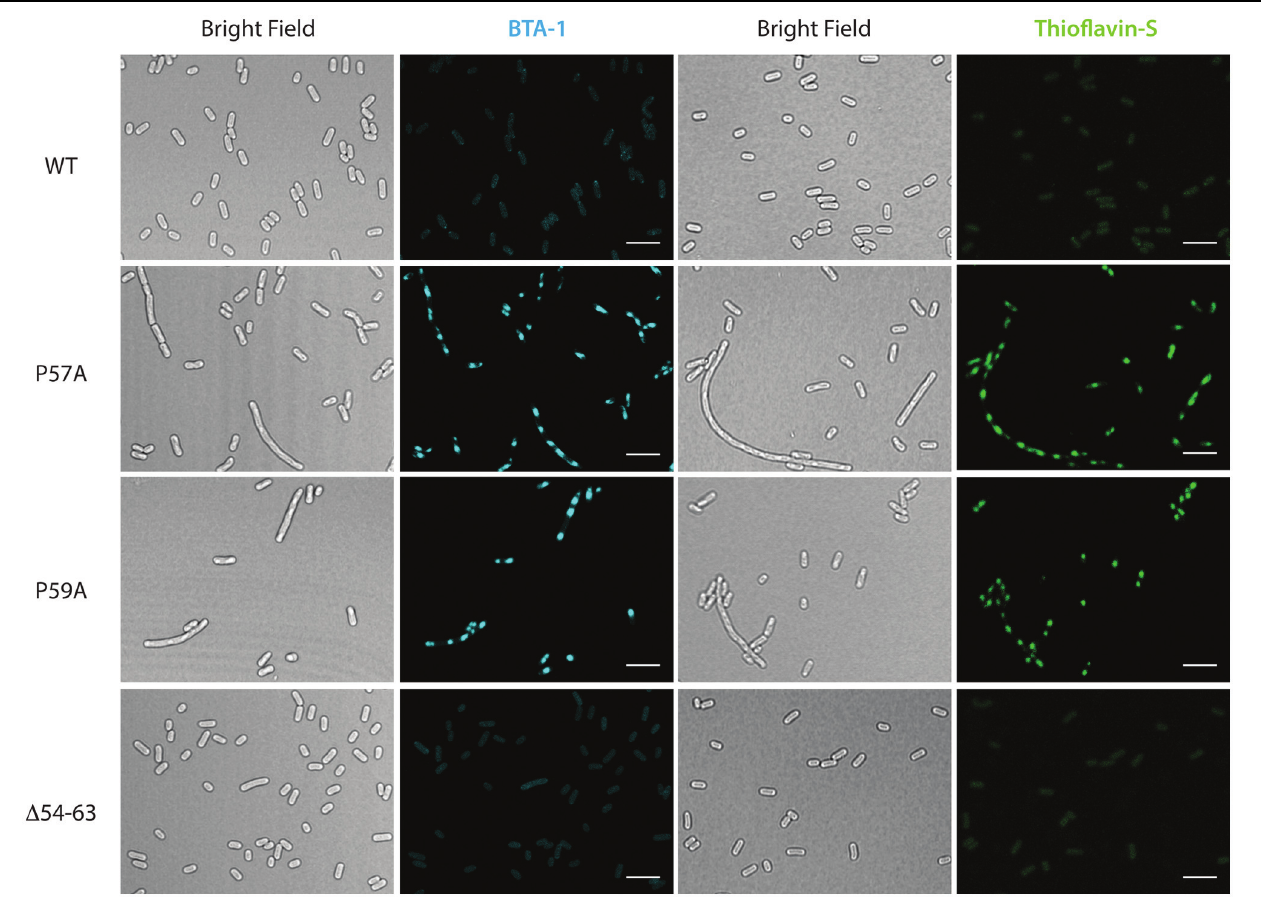
FIGURE 5 | Formation of amyloid inclusions in E. coli cells expressing MccE492 variants with altered aggregation propensity. p33pETAB constructs expressing different variants of MccE492 were transformed into E. coli BL21-AI cells. After 6 h of induction, cells were fixed with PFA, stained with either BTA-1 or ThS and visualized by confocal microscopy. Scale bar: 5 μ